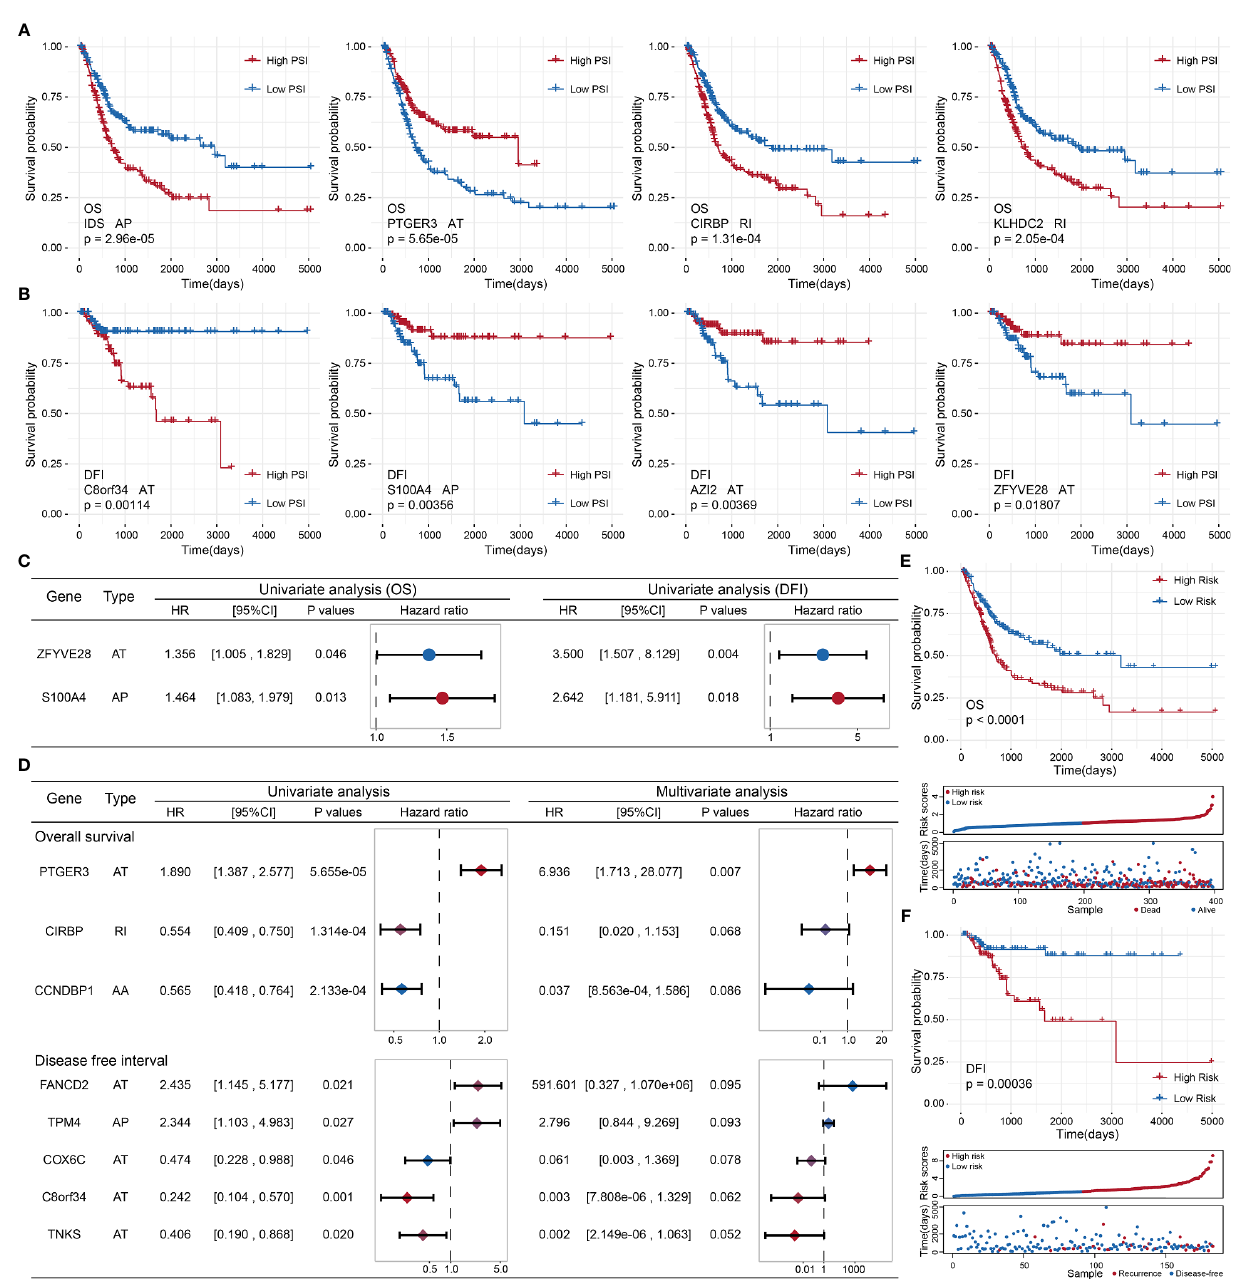
FIGURE 5 | (A) Kaplan – Meier curve of the four AS events associated with OS. (B) Kaplan – Meier curve of the top four AS events associated with DFI. (C) Comparison of AS events associated with OS and DFI in univariate Cox regression analysis of BLCA. (D) Comparison of univariate Cox analysis and stepwise Cox analysis of AS events associated with OS and DFI prognoses. (E, F) : Kaplan – Meier plot, risk score plot, and survival state plot of OS and DFI prognostic models for